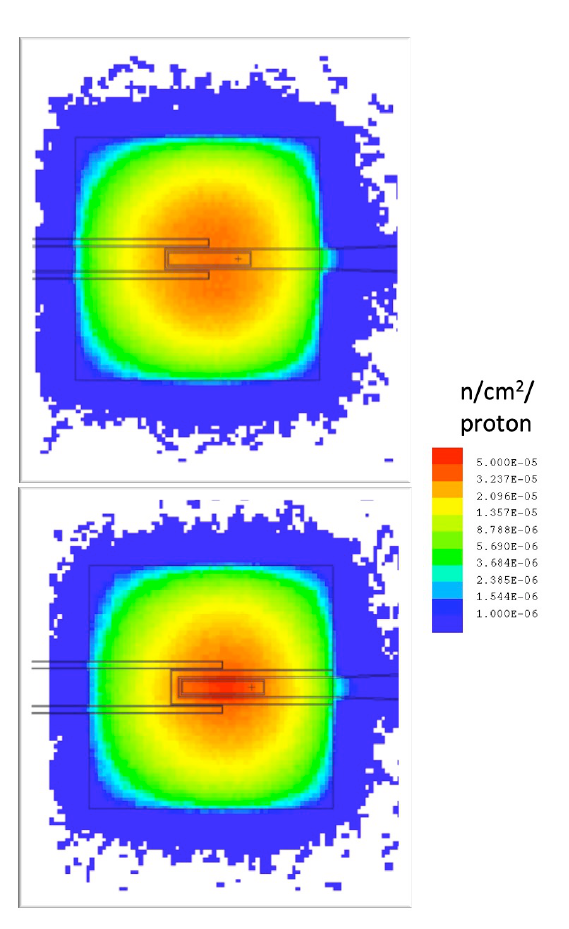
Fig. 6. Effect of the presence of premoderator on the thermal neutron fluence map ( E < 0.4 eV) in the compact source. Top figure: no premoderator. Bottom figure: 1.5-cm thick premoderator.